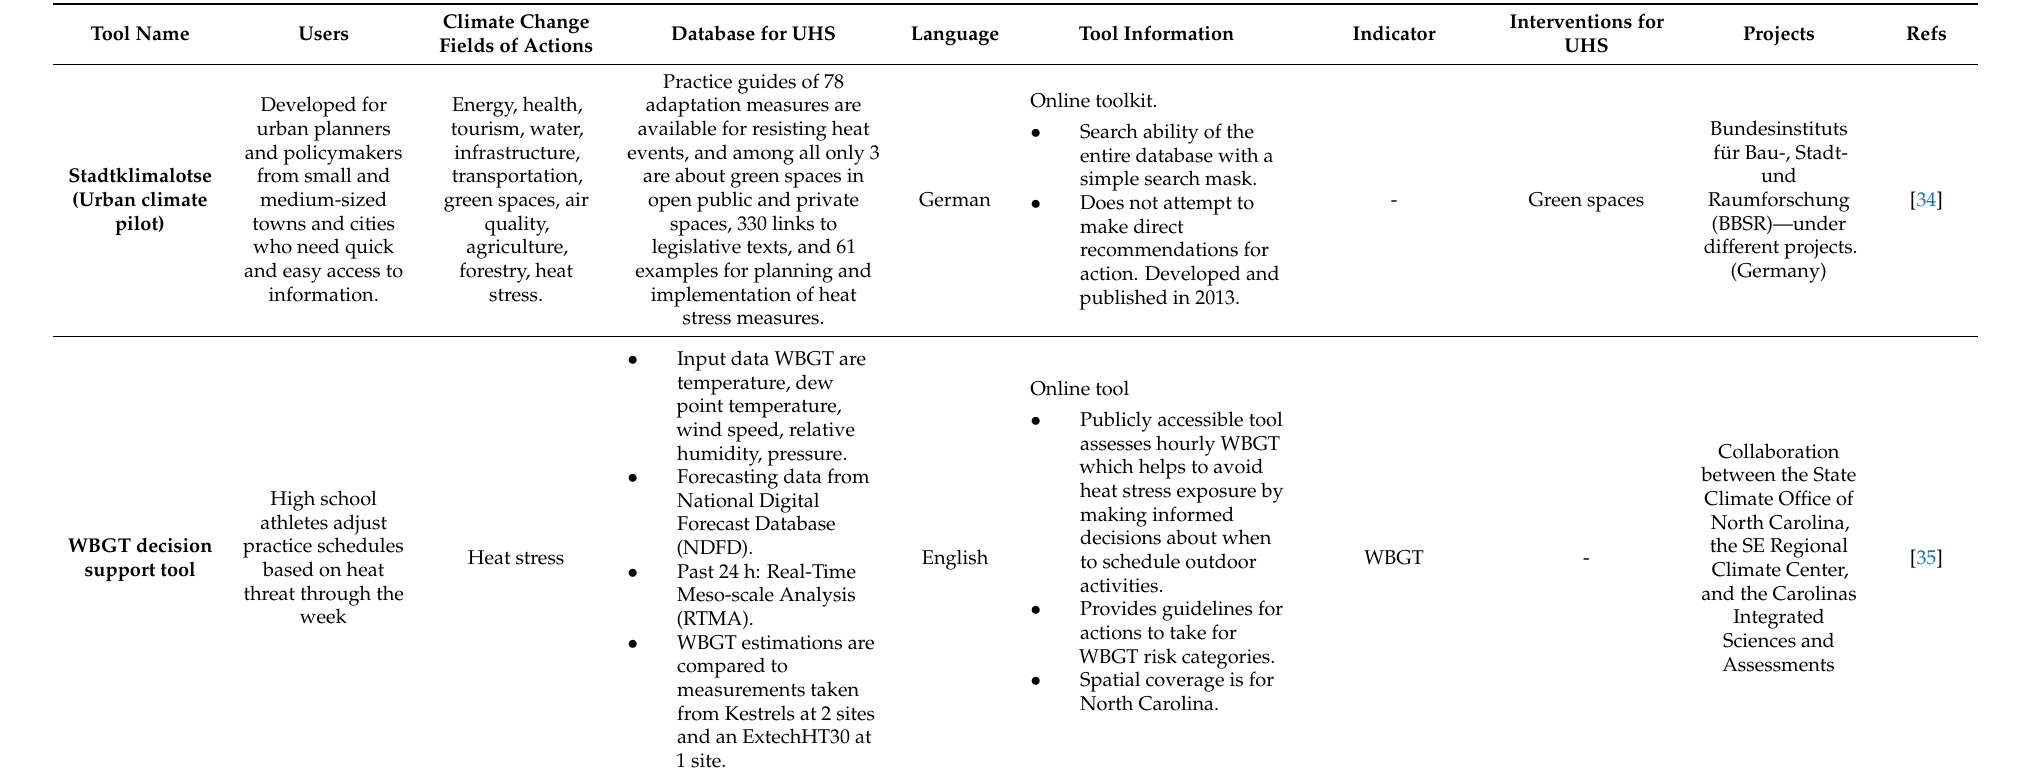
Table 2. Review of